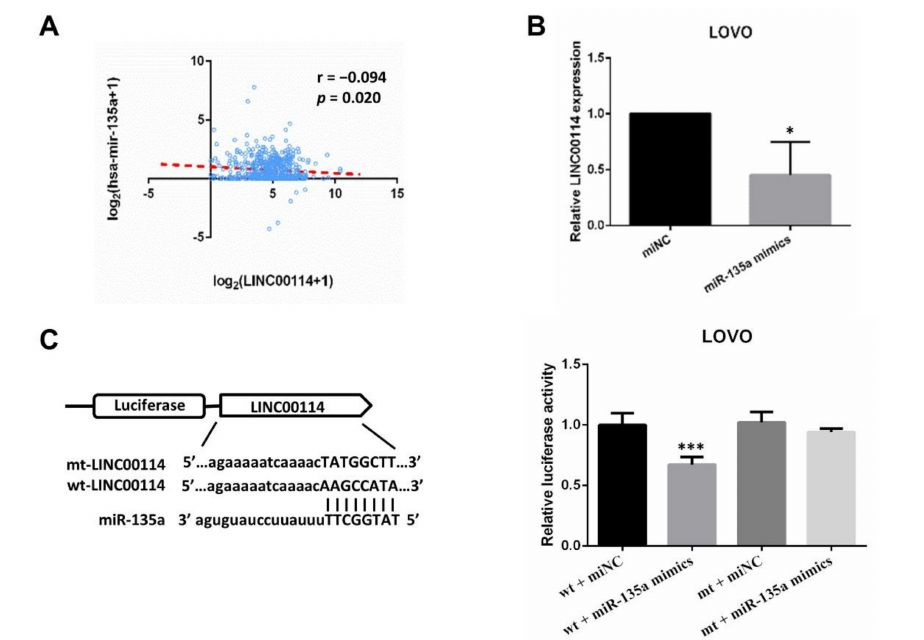
Figure 9. LINC00114 is the direct target of miR-135a. ( A ) Pearson’s correlation analysis showed that miR-135a was negatively associated with LINC00114. ( B ) The levels of LINC00114 were determined in negative control or miR-135a-mimic-transfected LOVO cells by qPCR. ( C ) Schematic illustration shows the miR-135a binding site and the reverse complementary sequence mutations in LINC00114. Luciferase assay was used to identify the miR-135a binding site. All data are expressed as mean ± SD of three independent experiments; * p < 0.05, *** p <